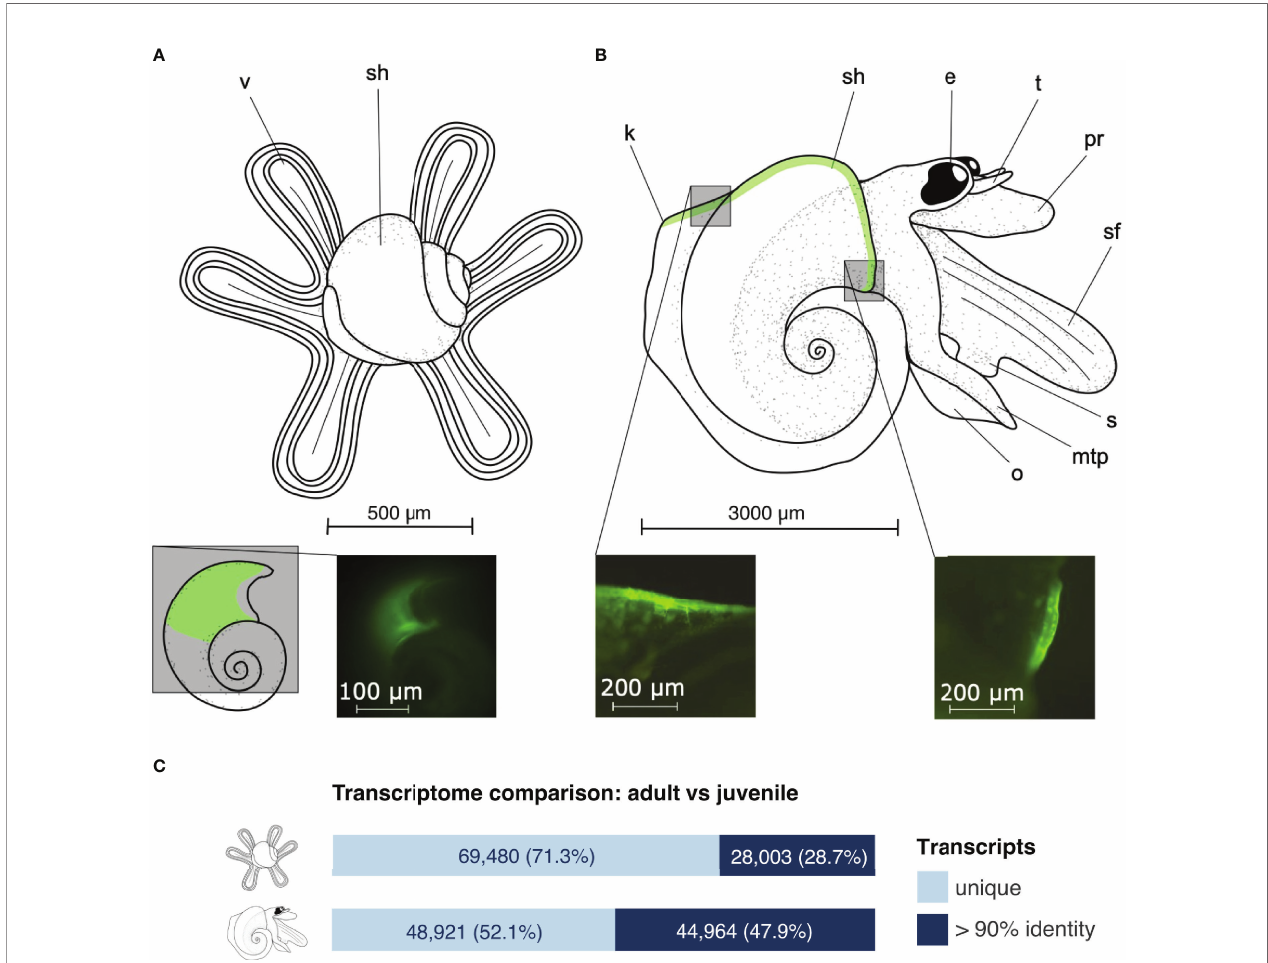
FIGURE 1 | External morphology of Atlanta ariejansseni juveniles (A) and adults (B) , supported by fl uorescence images of their shells stained with calcein, showing areas of active calci fi cation during the experiments. Key to morphology (from left to right): v, velum; sh, shell; k, keel; e, eye; t, tentacle; pr, proboscis; sf, swimming fi n; s, sucker; mtp, metapodium; o, operculum. At an early stage, juveniles have a four-lobed velum, which changes into a long and narrow six-lobed velum at a later stage shown here. When undergoing metamorphosis, the velum is digested. Shells are transparent with unique shell ornamentation and mature adults have a total of 4.5 to 4.75 whorls. Shell sizes range from 500 m m in juveniles to 3000 m m in adults. The soft tissue varies greatly in colour among individuals from mottled white to orange-pink and dark grey (Wall-Palmer et al., 2016a). The green shading in the drawings represents the regions stained with calcein. (C) Clustering between adult and juvenile Atlanta ariejansseni transcriptome assemblies: the fraction of identical transcripts is marked in dark blue, while the fraction of different transcripts is in light blue. Clustering was conducted with cd-hit-est-2d (identity > 90%) on the fi ltered transcriptome